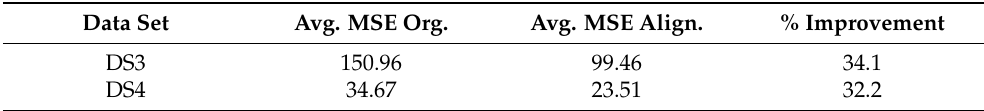
Table 2. Evaluation of improvement of the error between the WLAN estimator and GT after alignment of the WLAN estimator.